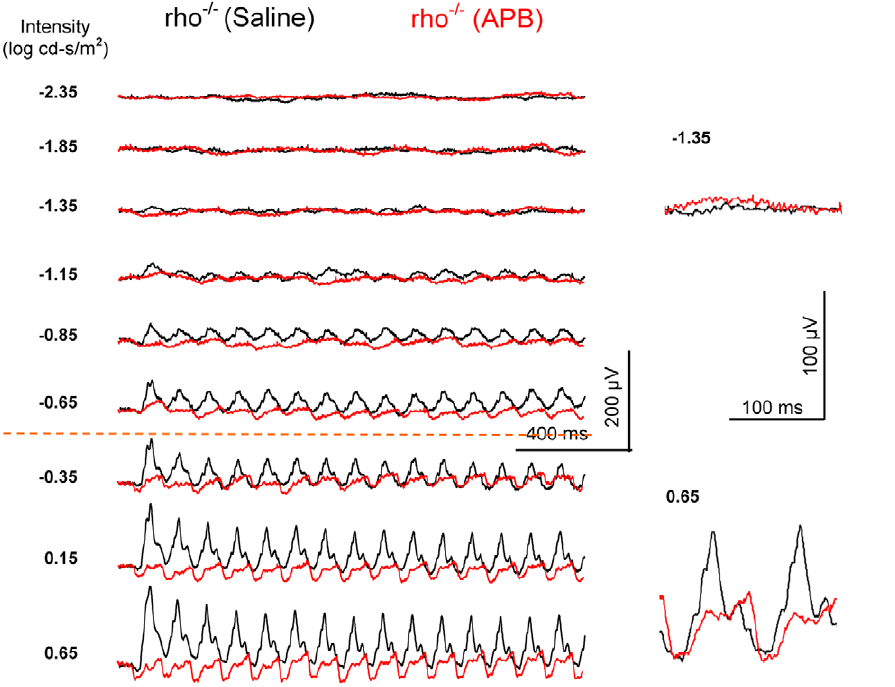
Figure 8. The effect of the ON-channel blocker APB on the light-adapted (background light 30 cd/m 2 ) 10-Hz flicker ERG of a rho 2 / 2 mouse. The black traces show ERGs of the saline-injected eye and the red traces show ERGs of the APB-injected contralateral eye. When compared with the control eye, the threshold of flicker ERG responses in the APB-injected eye increases and the amplitudes decrease.